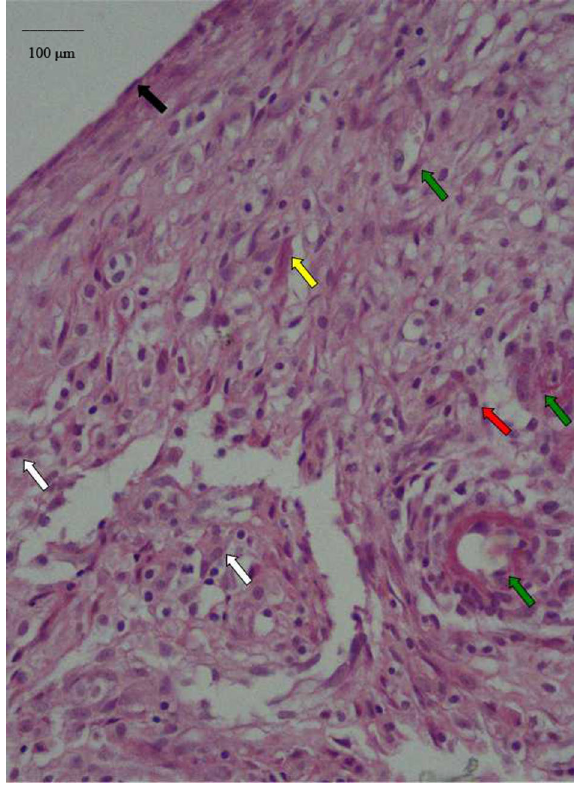
Figure 1. Hematoxylin-eosin staining of the serosa in a representative rat in group A (untreated). The serosa has an unrepaired dissection surface with discontinuous mesothelial cells (black arrow). Capillary proliferation (green arrow), fibro- blastic proliferation (red arrow), dense collagen fibers (yellow arrow), and infiltration of a large number of granulocytes and macrophages (white arrows) were observed (100 6